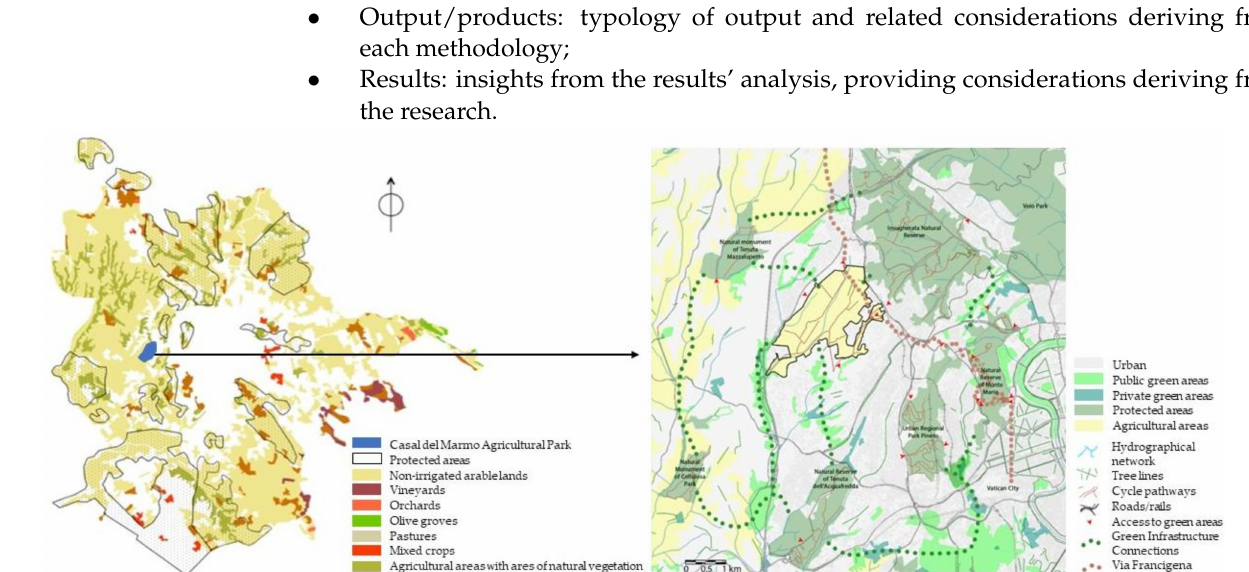
Figure 2. Land uses and protected areas in the Municipality of Rome, scale 1:100,000 (Source: Cavallo et al. (2014), using data from Corine Land Cover, 2006) ( Left ). Land use and paths surround- ing CMAP ( Right